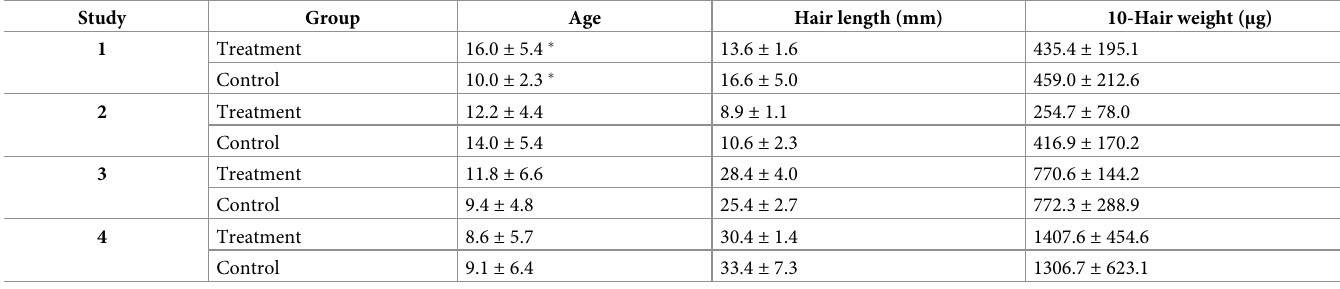
Table 1. Group characteristics of horses and ponies at the start of each study.